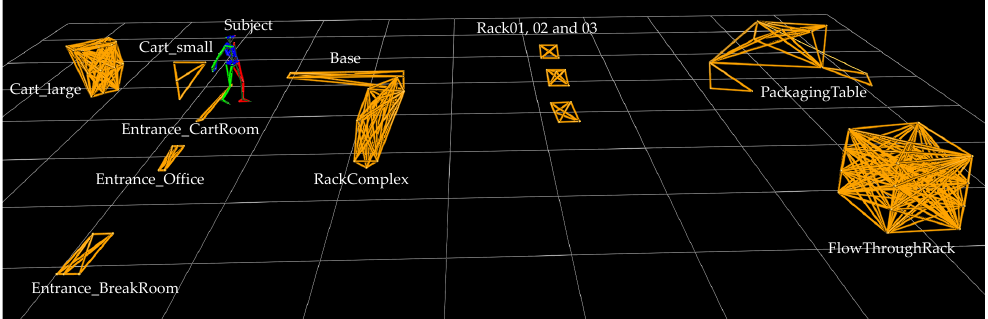
Figure 3. Entire laboratory set-up as an oMoCap